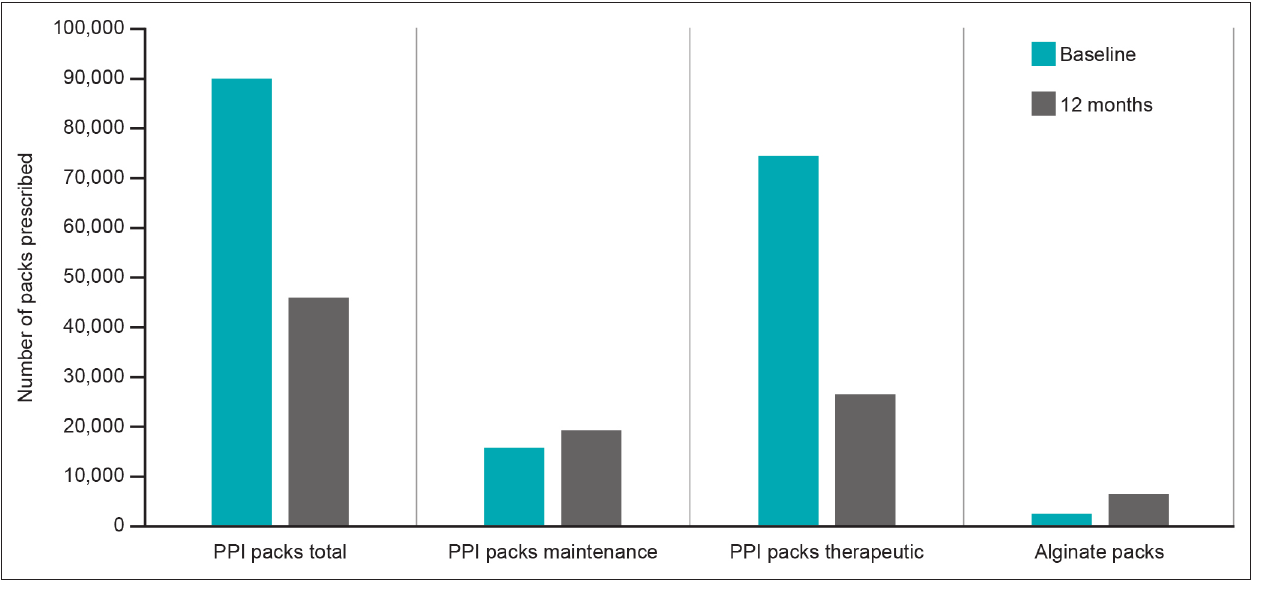
Figure 3 Net impact of DTREP programme on prescriptions DTREP = Dyspepsia Therapy Review and Education Programme. PPI = proton pump